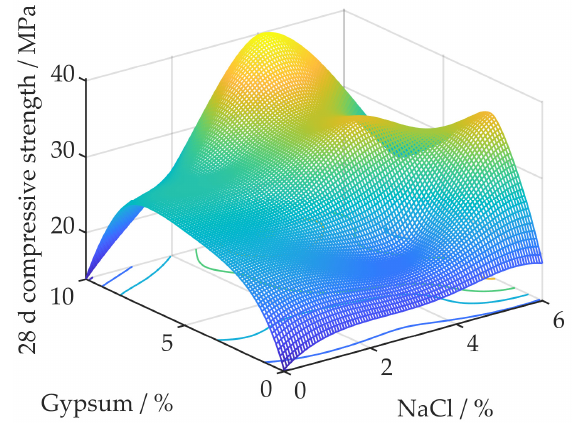
Figure 8. 28-day compressive strength of concrete.